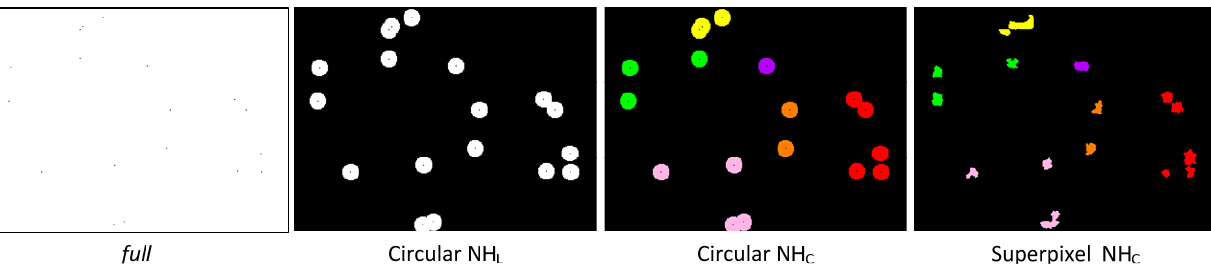
indicate the class label. The darker C